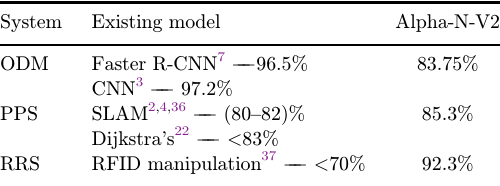
Table 5. Performance